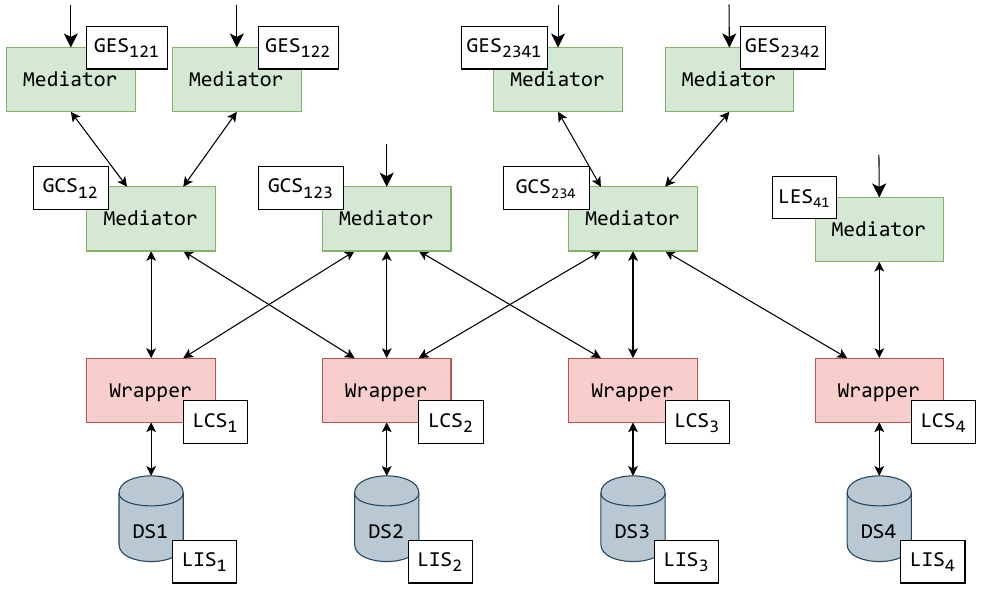
Figure 6. An exemplified assignment of schemas to a MW system with an exporting mediator